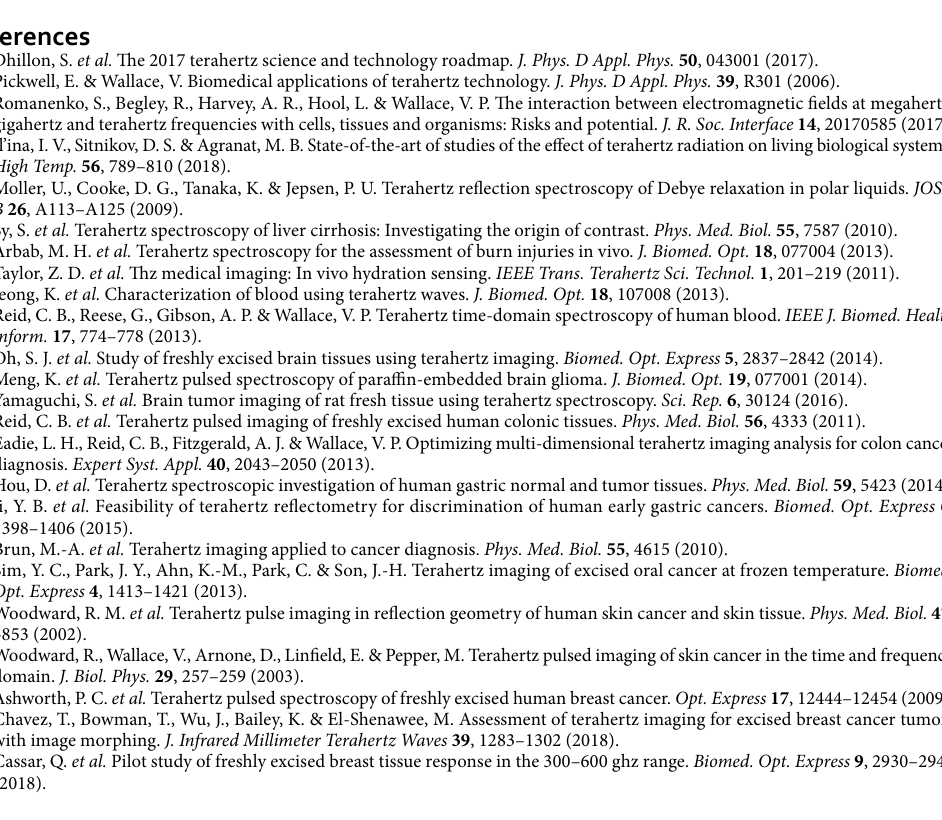
Figure 15. TS#3 tissue sample classification maps at 550-GHz for (cid:31) two best thresholds. “Not applicable” refers to regions where the binary pathology classification and the binary terahertz classification image do not match spatially. The values listed in each box are respectively standing for the refractive index threshold, the true positive rate and the false positive